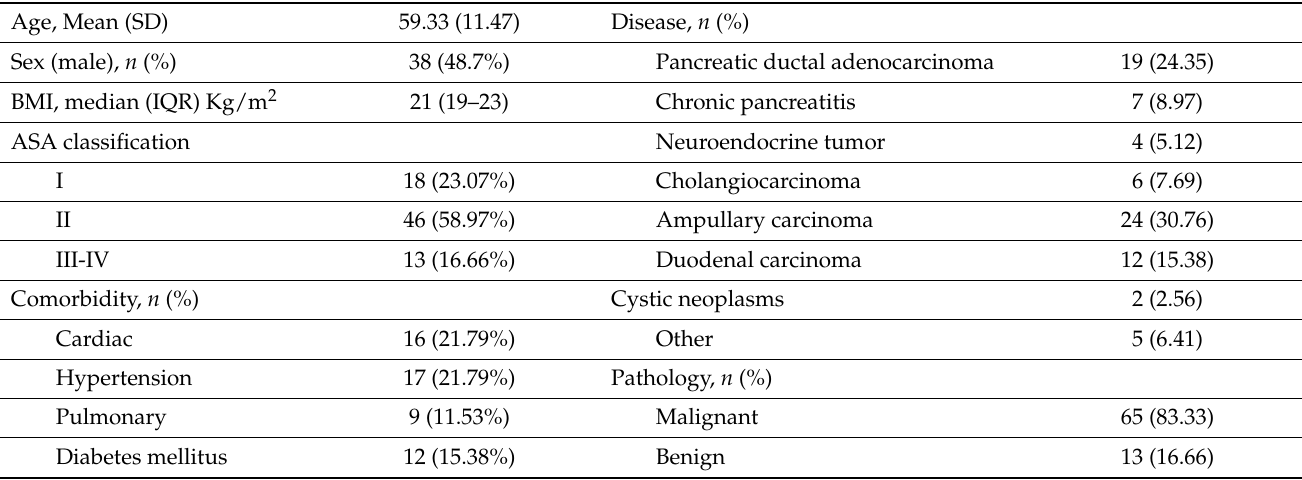
Table 1. Baseline characteristics of the retrospective group.